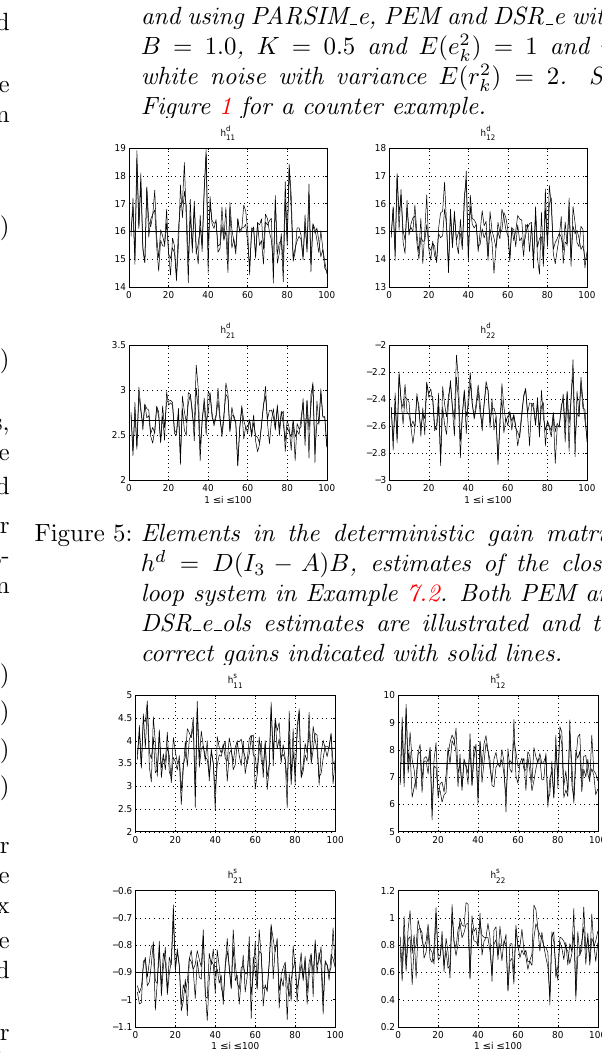
Figure 6: Elements in the Kalman filter stochastic gain matrix, h s = D ( I 3 − A ) − 1 K + I 2 , estimates of the closed loop system in Example 7.2. Both PEM and DSR e ols estimates are illustrated and the correct gain solid